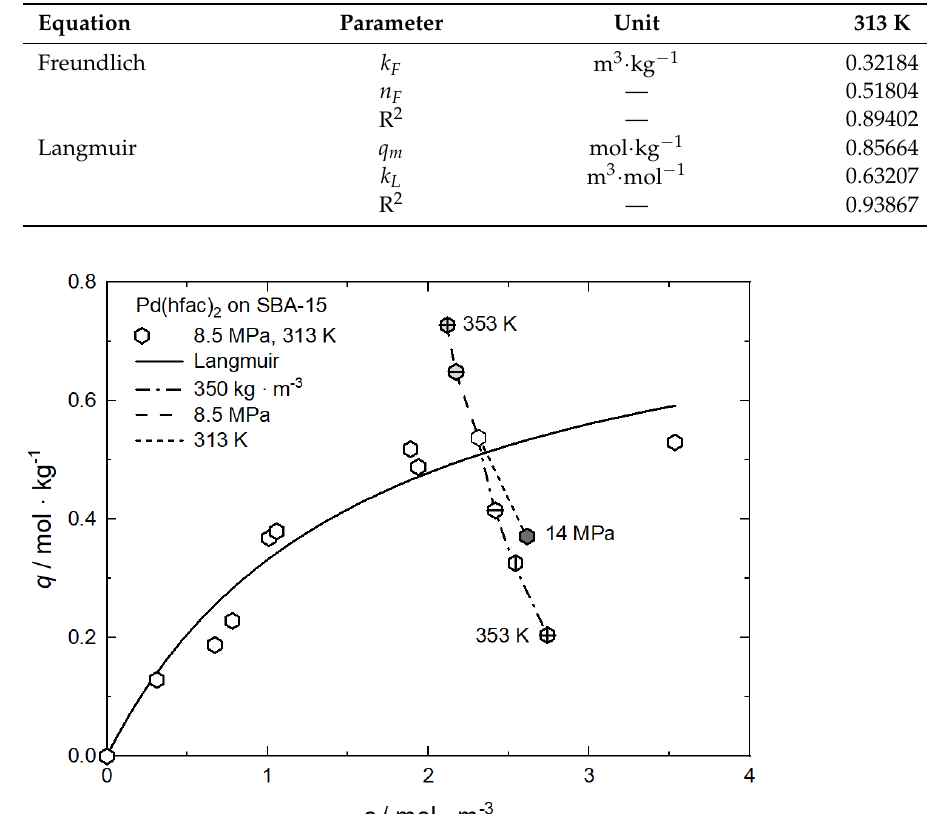
Table 7. Adsorption isotherm parameters for AgNO 3 from scCO 2 solution on SBA ‐ 15 at 𝜌 = 792 kg ∙ m − 3 and different temperatures [59].